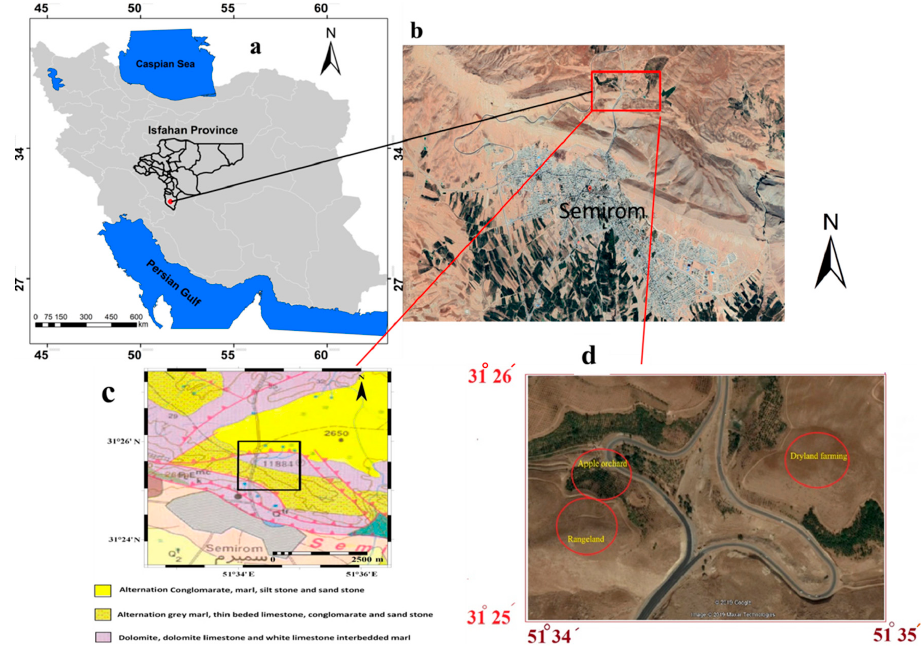
Figure 1. Location of the study area. ( a ) Isfahan province among all the provinces in Iran, ( b ) location of the study area in the Semirom district, ( c ) geology map and the geological formations in the region, and ( d ) location of three land uses in the study